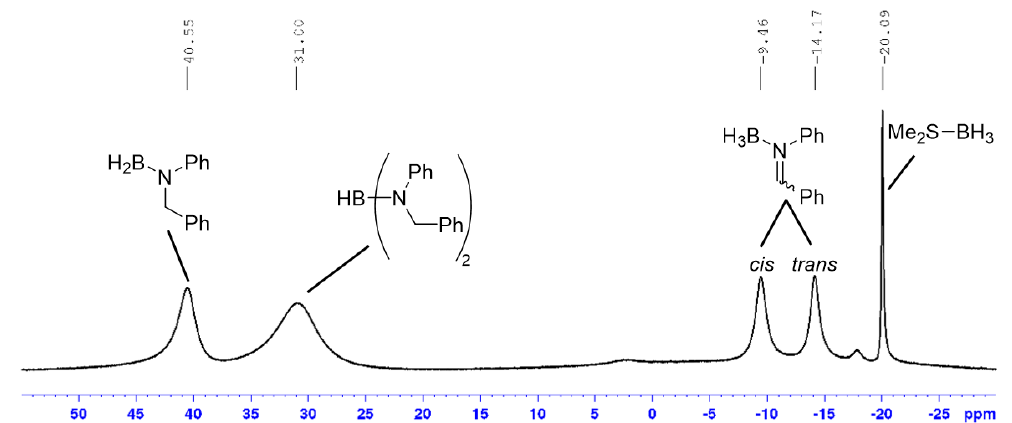
Figure 1. 11 B[ 1 H]-NMR spectrum of a mixture (1:1) between Me 2 S-BH 3 and N -benzylideneaniline after 6 hours.